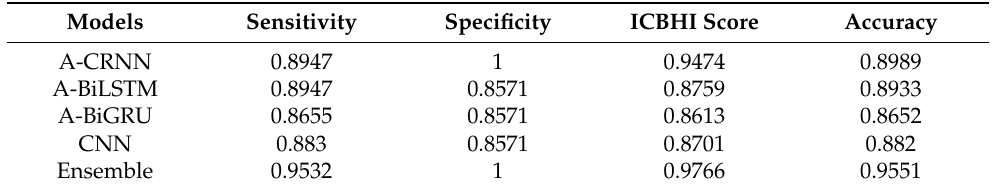
Table 14. Results of base and ensemble models using a subject-independent train–test split for D1, i.e., the ICBHI dataset.